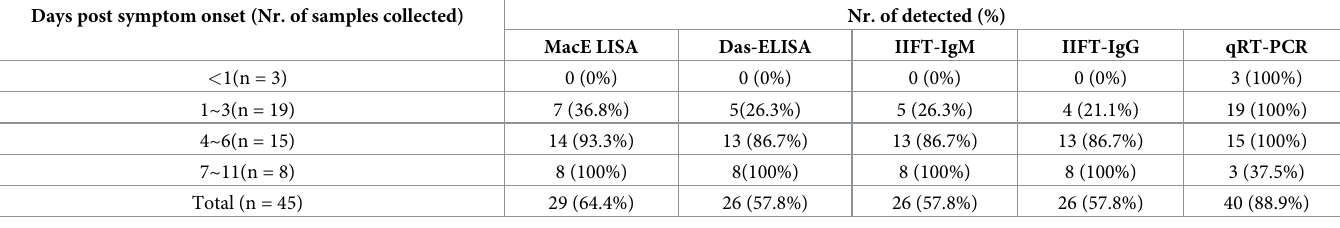
Table 2. CHIKV specific antibodies detection in the sera of laboratory diagnosed patients � . Days post symptom onset (Nr. of samples collected)